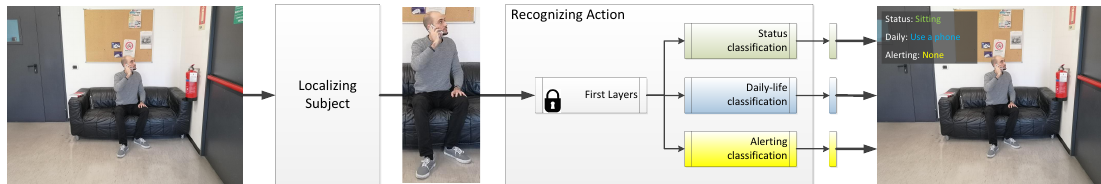
Figure 4. Schema of the proposed monitoring approach. Each processing step is implemented with algorithms based on Deep Learning. Subject localization is based on the Faster R-CNN network. For action recognition two networks are evaluated: I3D and DeepHar. We modified these networks to take advantage of a multi-branch approach where groups of actions and states are recognized